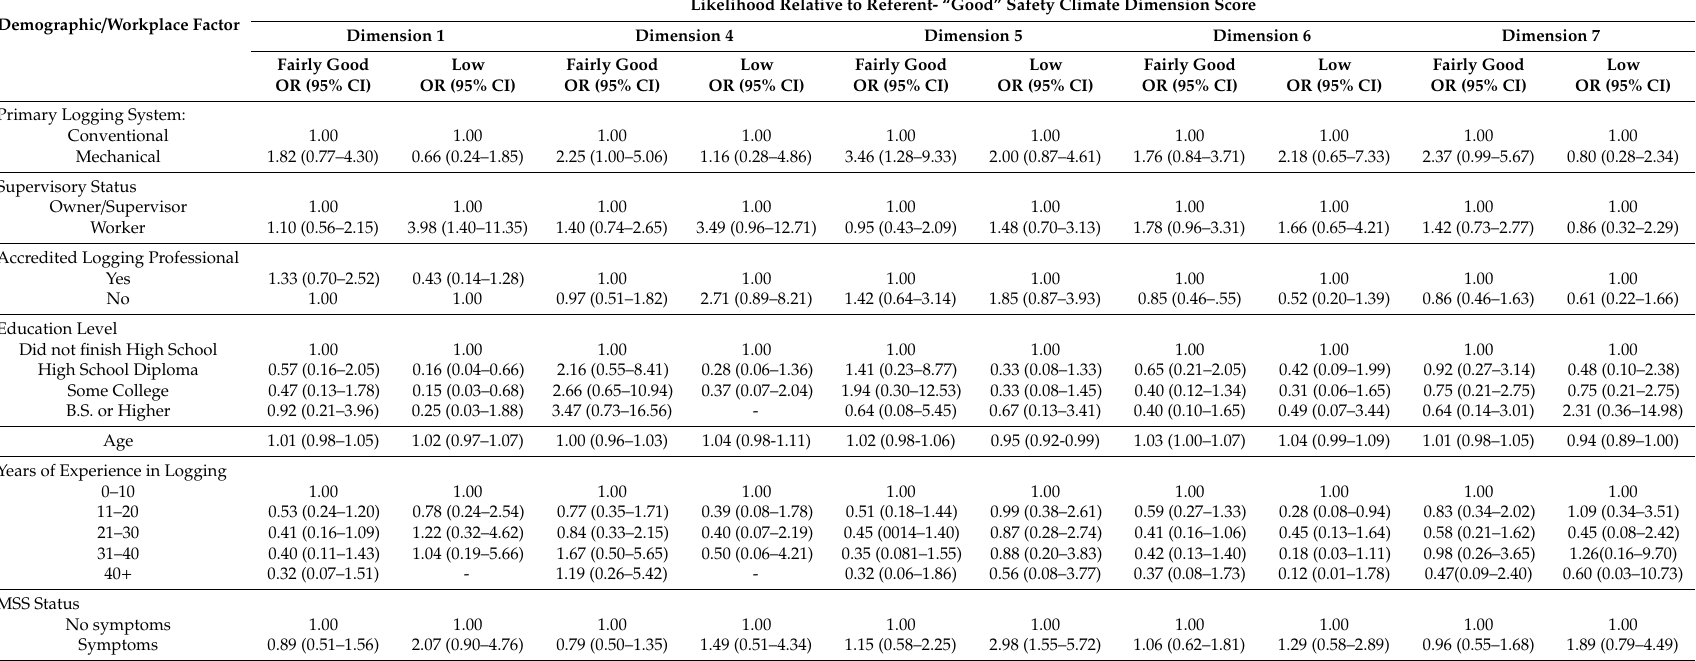
Table 4. Montana logging survey 2017: Multinomial logistic regression